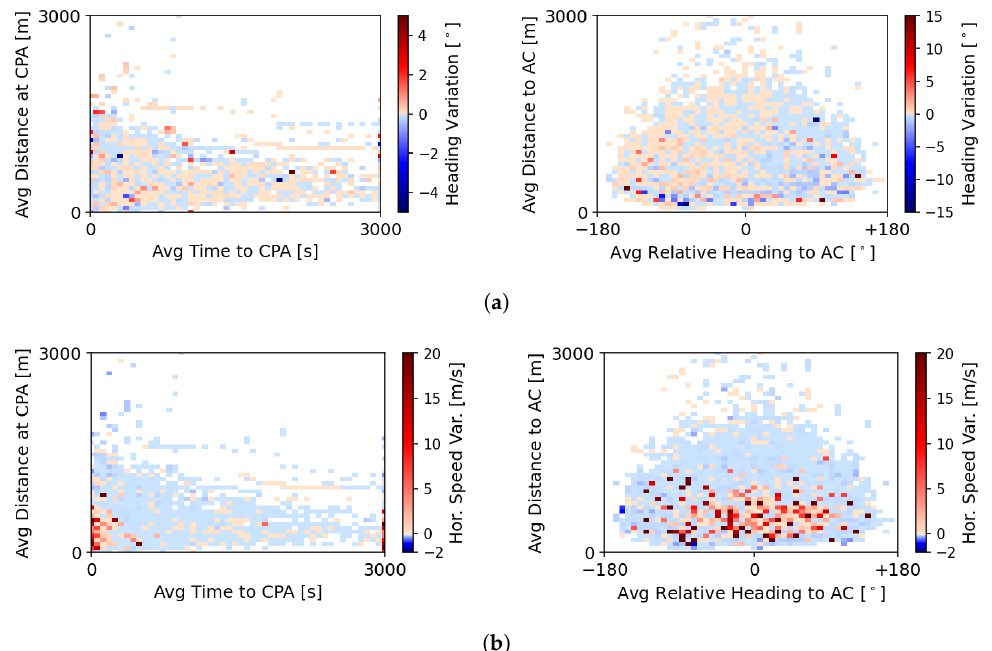
Figure 9. State variation output by the hybrid RL + MVP methods for conflict resolution in the training scenarios. ( a ) Heading variation performed by the hybrid RL + MVP methods. ( b ) Horizontal speed variation performed by the hybrid RL + MVP